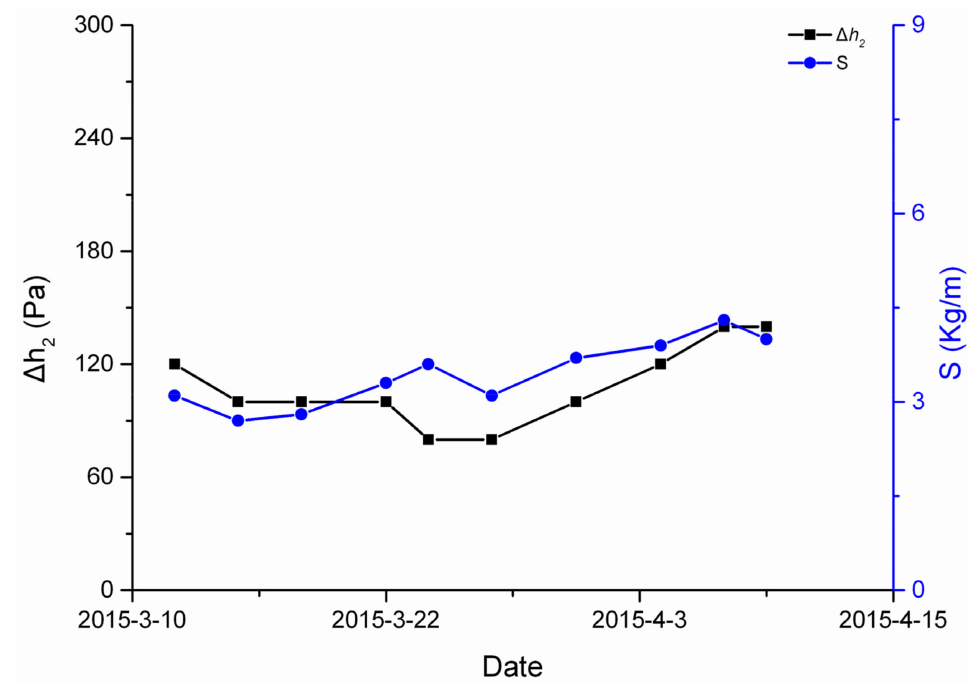
Figure 4. Changes of conventional